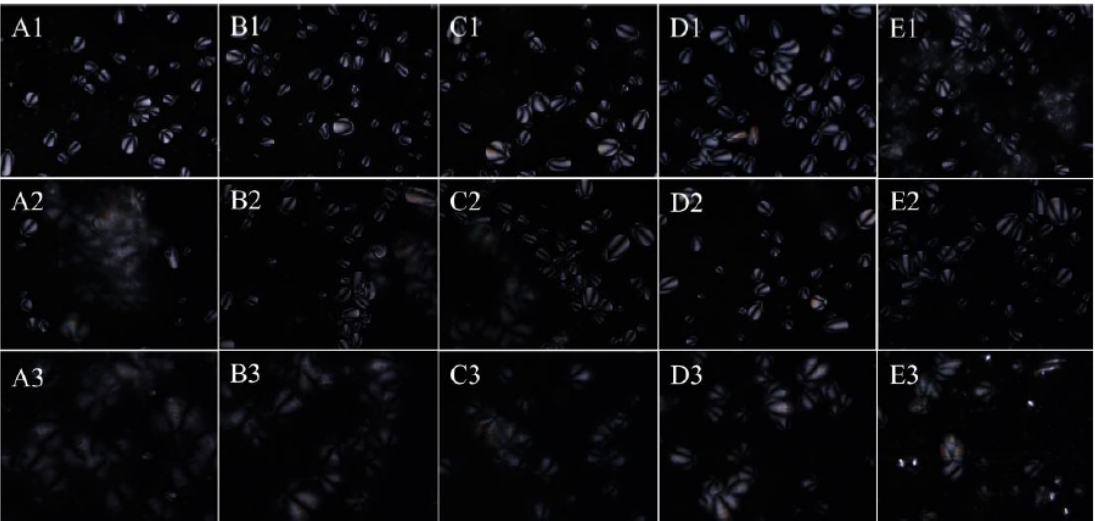
Figure 4. Polarized light microscopy of CS/KGM mixtures (200 × ). CS/KGM mixtures at different KGM concentrations (CS/0.3% KGM, 0.6% KGM, 0.9% KGM, and 1.2% KGM), were incubated at 60 ◦ C ( A1 – E1 ), 70 ◦ C ( A2 – E2 ), 95 ◦ C ( A3 – E3